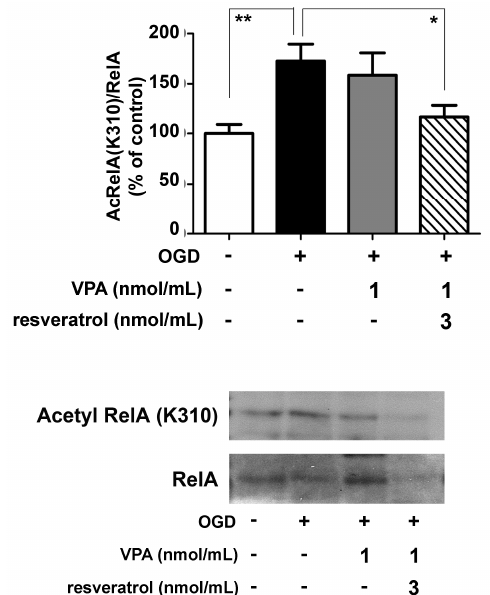
Figure 3. Effect of the valproate (VPA) and resveratrol combination on RelA acetylation state in OGD-exposed primary cortical neurons. Co-immunoprecipitation (co-IP) analysis of RelA acetylation in nuclear extracts of OGD-exposed cells treated during the following 2 h with vehicle or drugs. The combination of the drugs (VPA 1 nmol/mL and resveratrol 3 nmol/mL) site-specifically decreased the RelA K310 acetylation. In the densitometry analysis of immunoblot bands relative to RelA, data were expressed as percentage of the corresponding control value. Bars depicted the mean ± s.e.m. of three separate experiments, * p < 0.05 and ** p < 0.01 versus the corresponding OGD value.